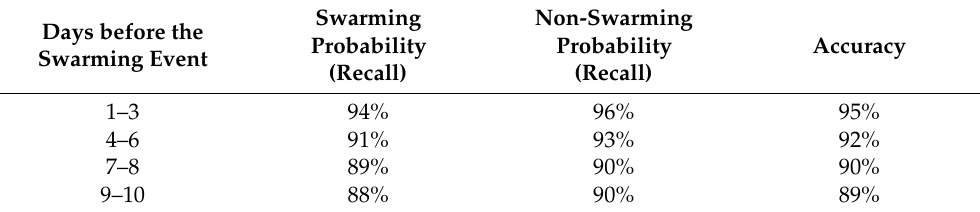
Table 12. Results of the U-Net CNN